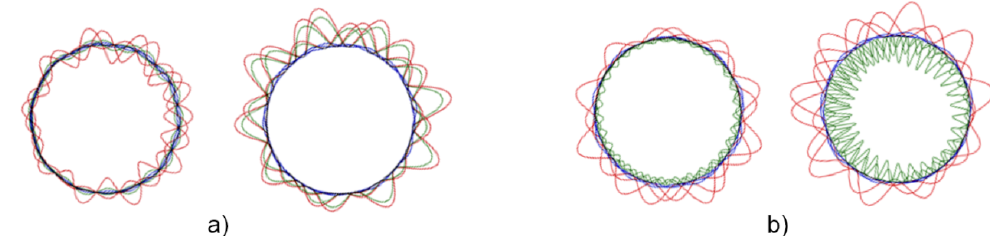
Figure 5. ( a ) Centered vs. displaced ripple’s origin and ( b ) negative ripple representation ( − 0.12 dB and − 2.45 dB).